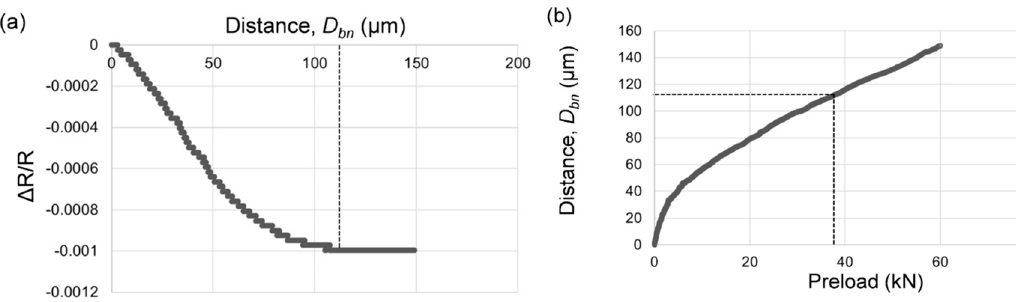
Figure 10. ( a ) Variation in the resistance change ratio with the distance D bn and ( b ) relationship between corresponding preload and the distance D bn .